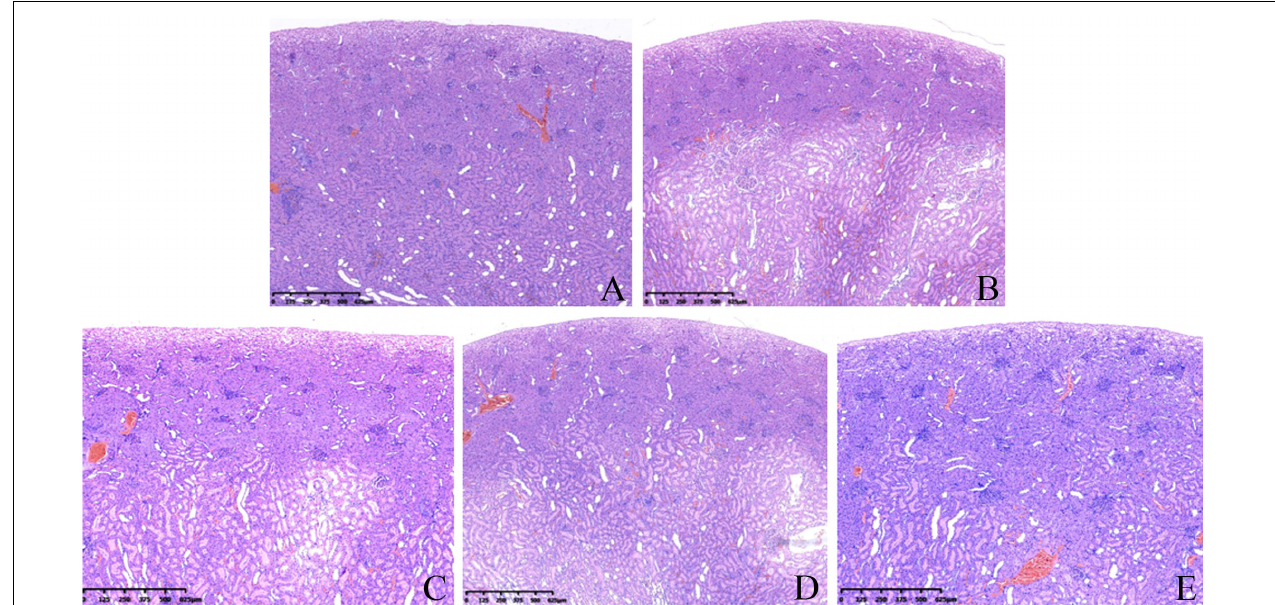
FIGURE 6 | Effects of AGO and GW117 on the histopathological changes in the kidneys in rats. (A) 0.5% CMC; (B) AGO 800 mg/kg; (C) GW117 800 mg/kg; (D) GW117 400 mg/kg; (E) GW117 200